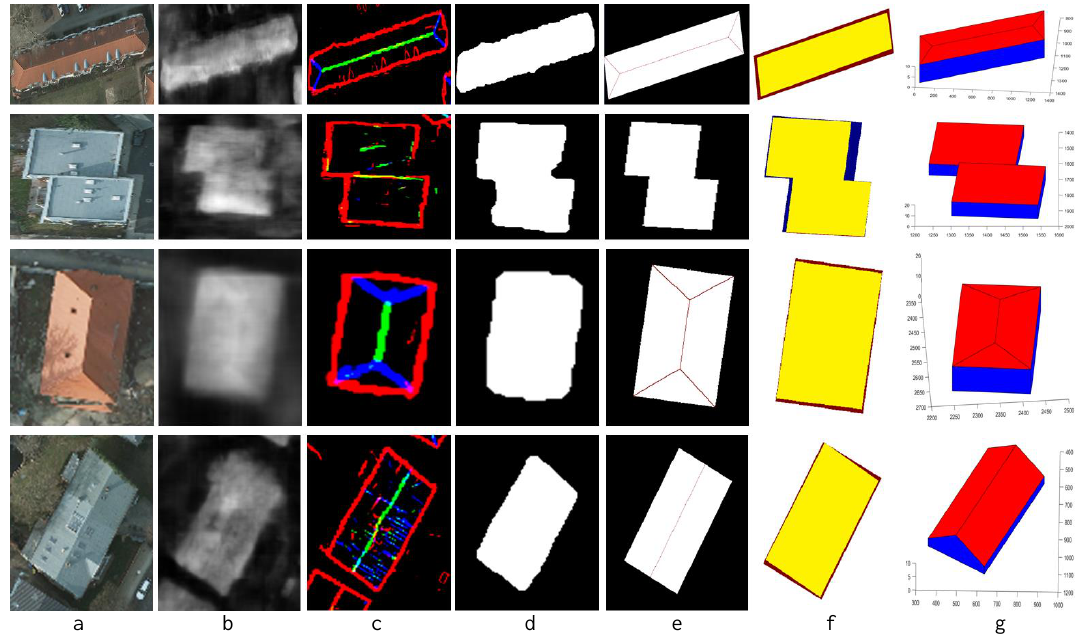
Figure 9. The results of 3D building reconstruction: a: the input RGB image; b: predicted nDSMs; c: predicted rooflines; d: binary polygons, extracted from eave lines; e: approximated polygons and best fitted ridge lines; f: differences between the building footprints and the ground truth; g: 3D models of roofs in